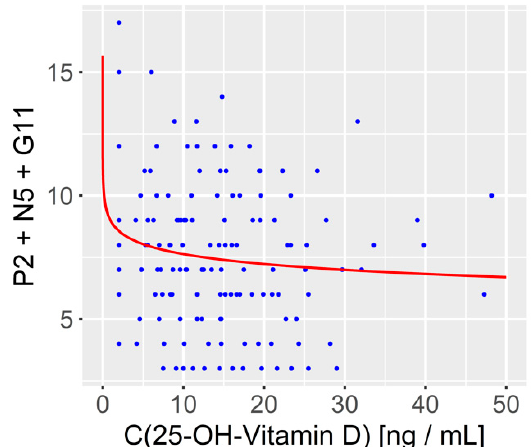
Figure 4. The relationship between 25-OH vitamin D levels and the cognitive component of the PANSS five factor model derived from items P2, N5 and G11 of the PANSS. As for the other cognitive variables, curve fitting indicated that the cognitive component ( y -axis) could be best described as a function of the logarithm of the 25-OH-vitamin D concentration ( x -axis).